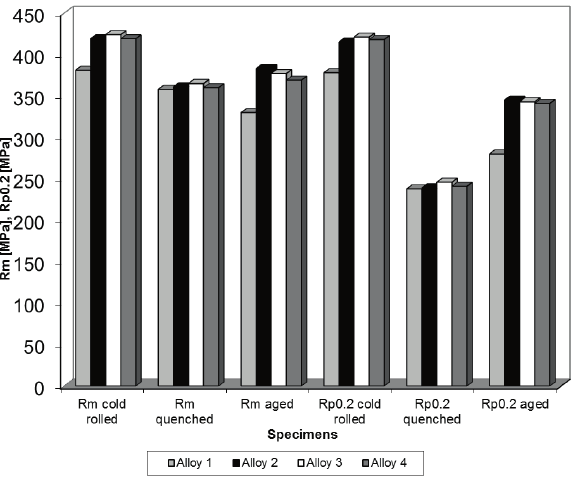
Figure 2. Ultimate strength (Rm) and Rp 0:2 (yield strength) of cold rolled, quenched and aged specimens of the alloys.